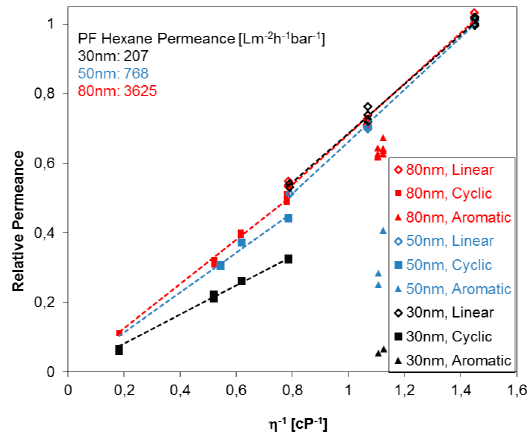
Figure 5. Relative permeance (dimensionless) of PC track-etched membranes with 30, 50 and 80 nm pore diameters against reciprocal dynamic viscosity of linear, cyclic, and aromatic PF compounds.